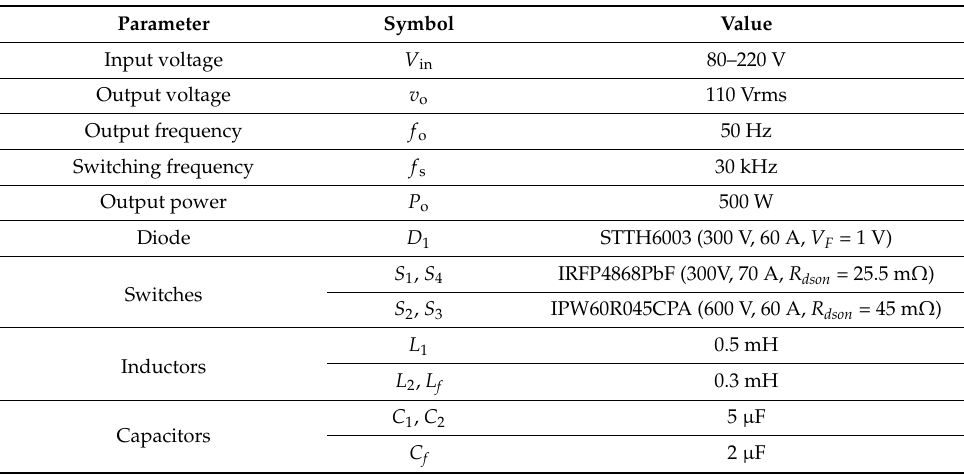
Figure 7. Photo of the laboratory prototype. ( a ) Prototype. ( b ) Measurement setup. Table 4. Parameters for the